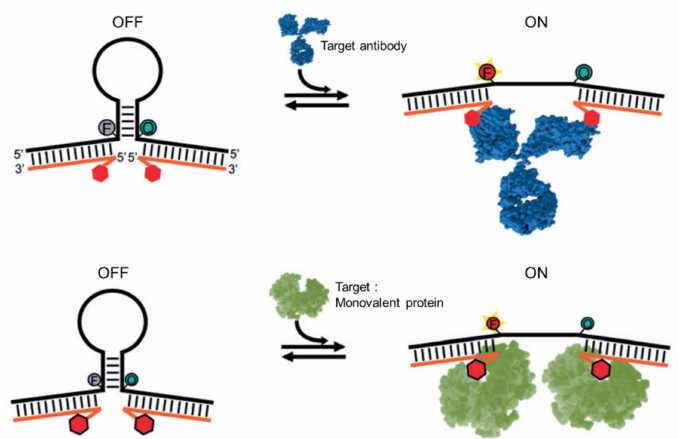
Figure 11. The structure and principle of a DNA-based beacon for the detection of antibodies. The antibody exerts steric strain on the beacon and changes the distance between a fluorophore and quencher. Reproduced by permission from John Wiley & Sons Ltd.: Angew. Chem. Int. Ed. 2015, 127, 13412–13416, doi:10.1002/ange.201505179. Copyright (2015) [95].